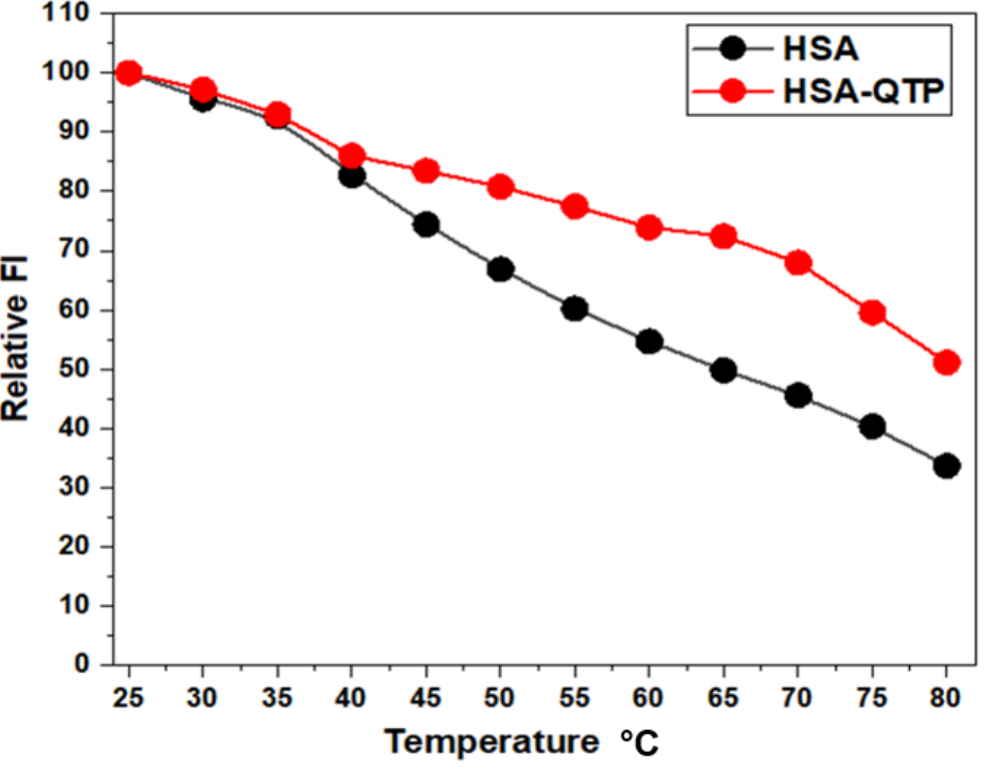
Figure 7. Thermal stability profiles of HSA and the QTP-HSA (1:10) system in the temperature range, 25–80 ◦ C, as monitored by fluorescence intensity measurements at 343 nm (FI 343 nm) using a protein concentration of 5 µ M in 60 mM sodium phosphate buffer, pH